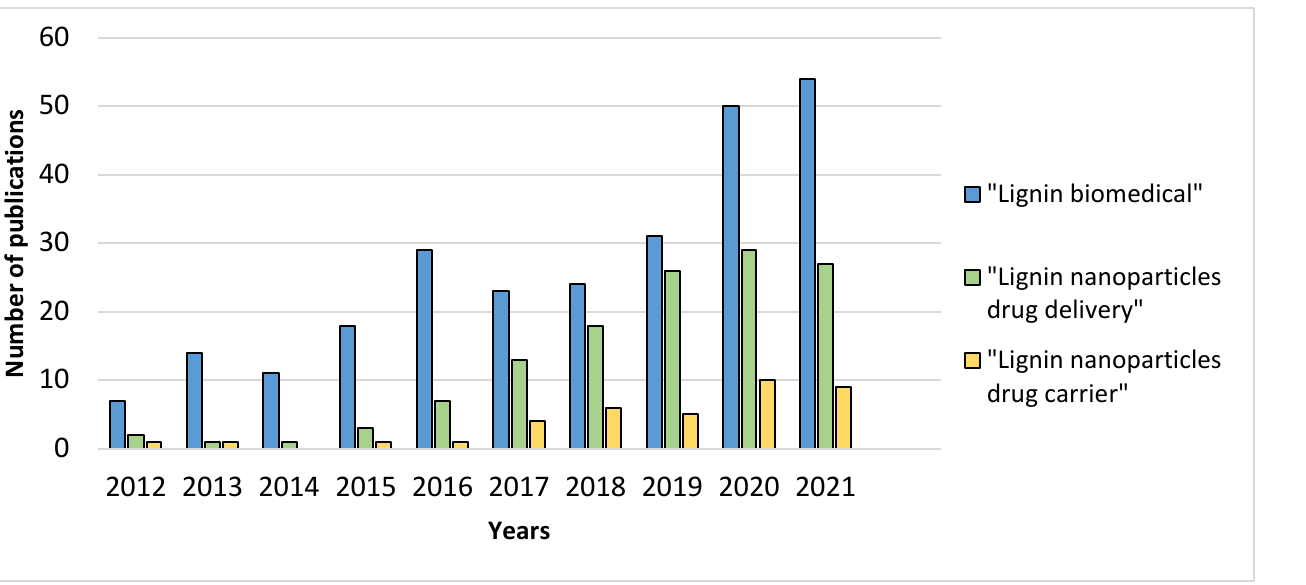
Figure 4. Number of publications per year on the use of lignin in the biomedical field (Web of Science TM ).